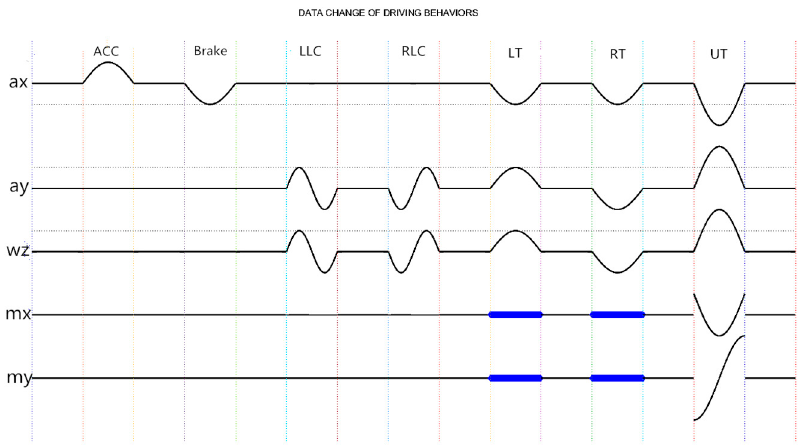
Figure 5. Data change rule of different driving behaviors.